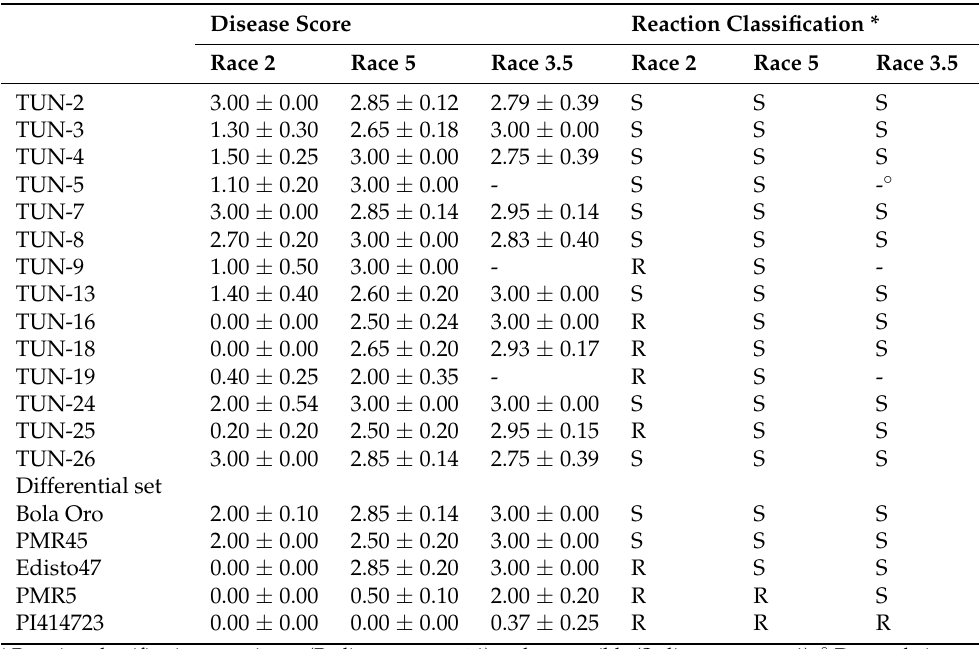
Table 2. Phenotypic evaluation of the resistance to P. xanthii Races 2, 5, and 3.5, by artificial inoculation in growth chamber conditions. Values are mean (n = 12) ± SE.